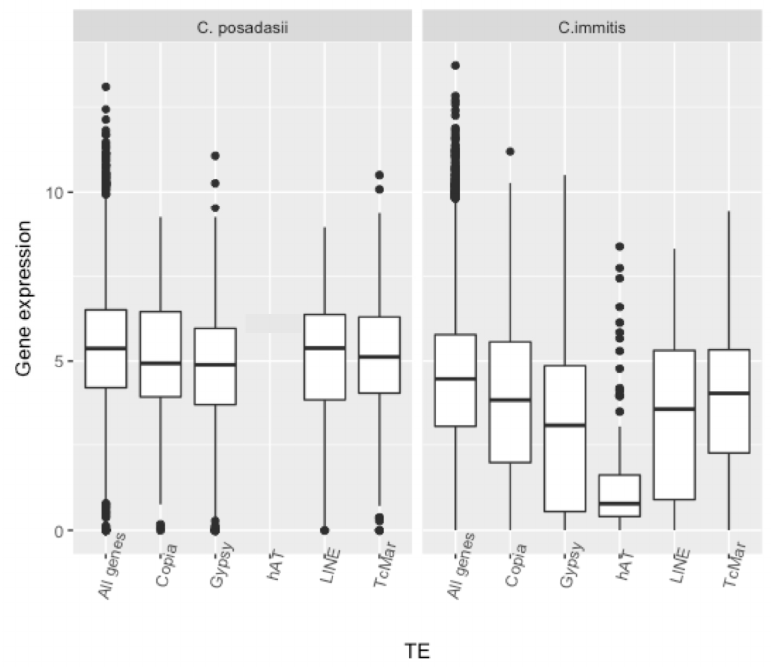
Figure 5. Mean expression values (log 2 FPKM) of C. immitis and C. posadasii loci within 1 kB of TE superfamilies compared to all loci. The p -values for C. posadasii genes associated with Gypsy were 5 × 10 − 3 and all others were not significant. The p -values for C. immitis genes associated with any TE superfamily were all ≤ 1 × 10 − 4 ; p -values for C. immitis genes associated with Gypsy or hAT TEs were ≤ 1 × 10 − 10 .